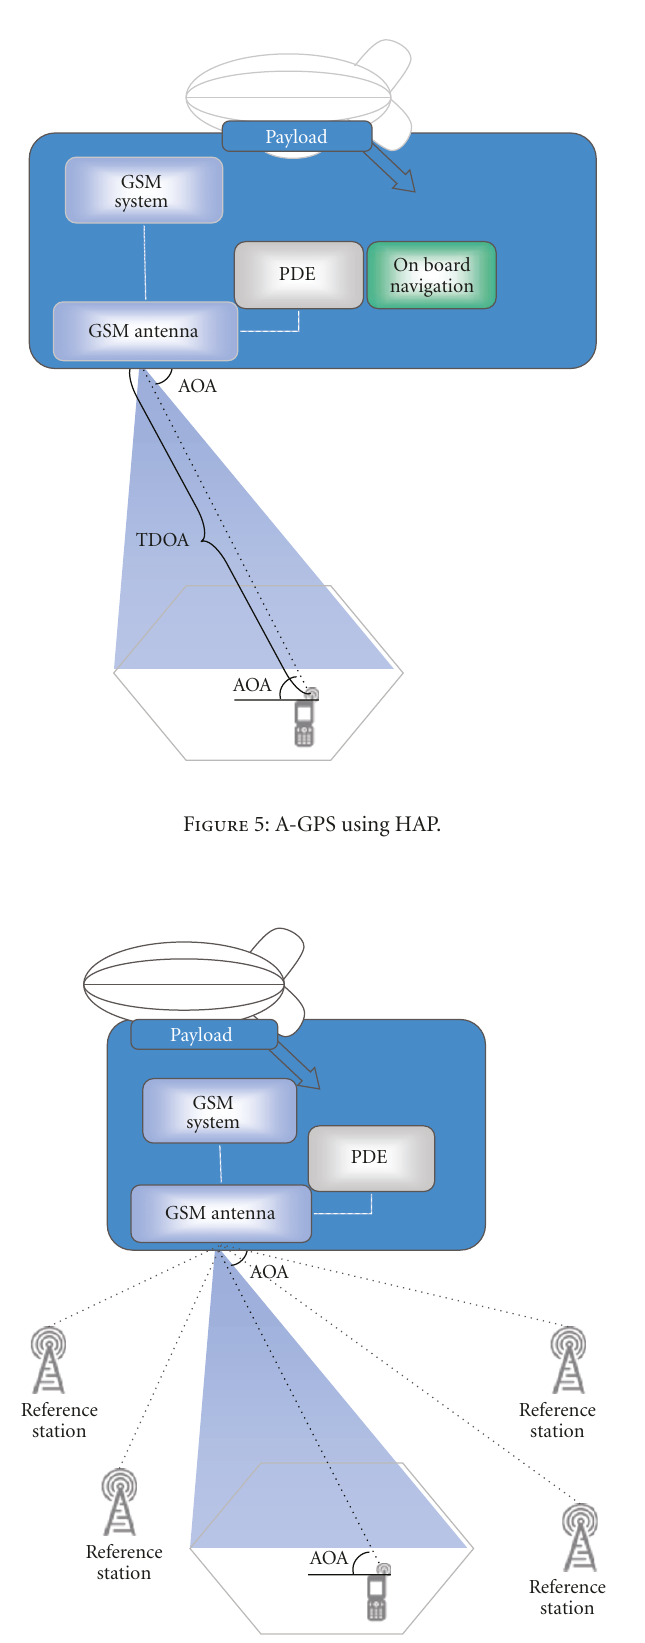
Figure 6: Using reference stations.